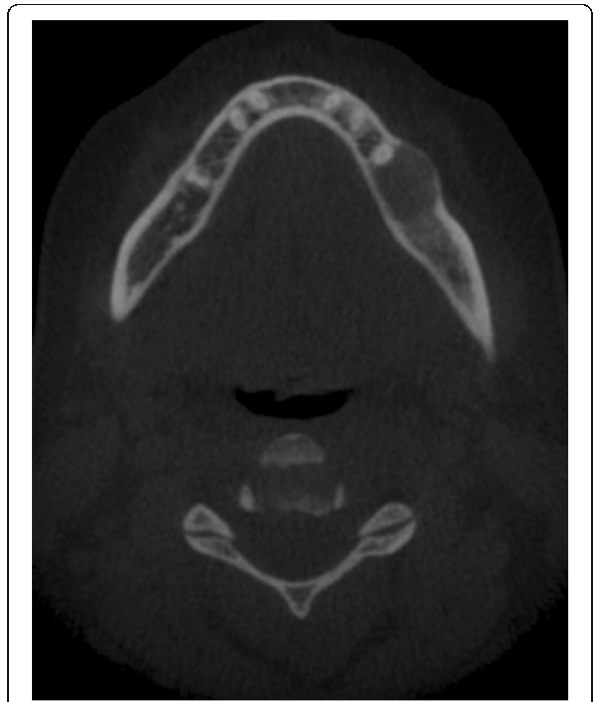
Fig. 3 CT of the same patient showed a solitary expansile left mandibular low density lesion with associated cortical